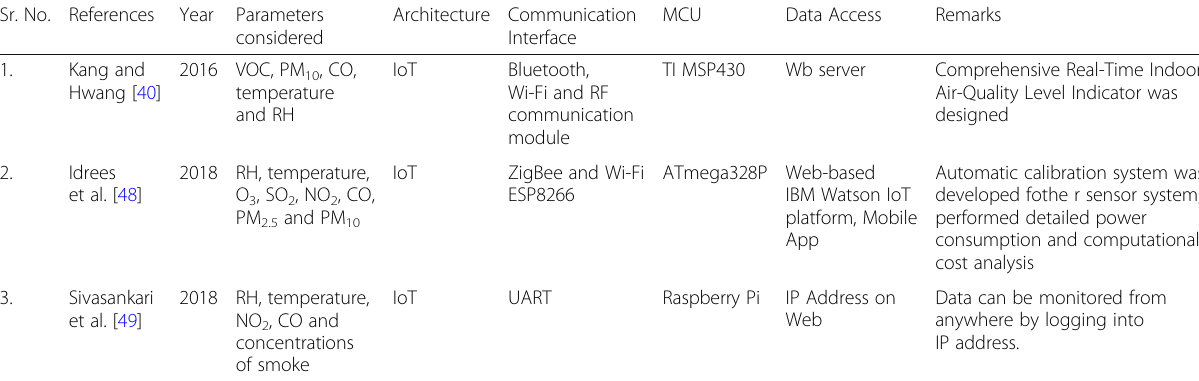
Table 3 Summary of IAQ monitoring systems based on IoT Sr. No. References Year Parameters considered